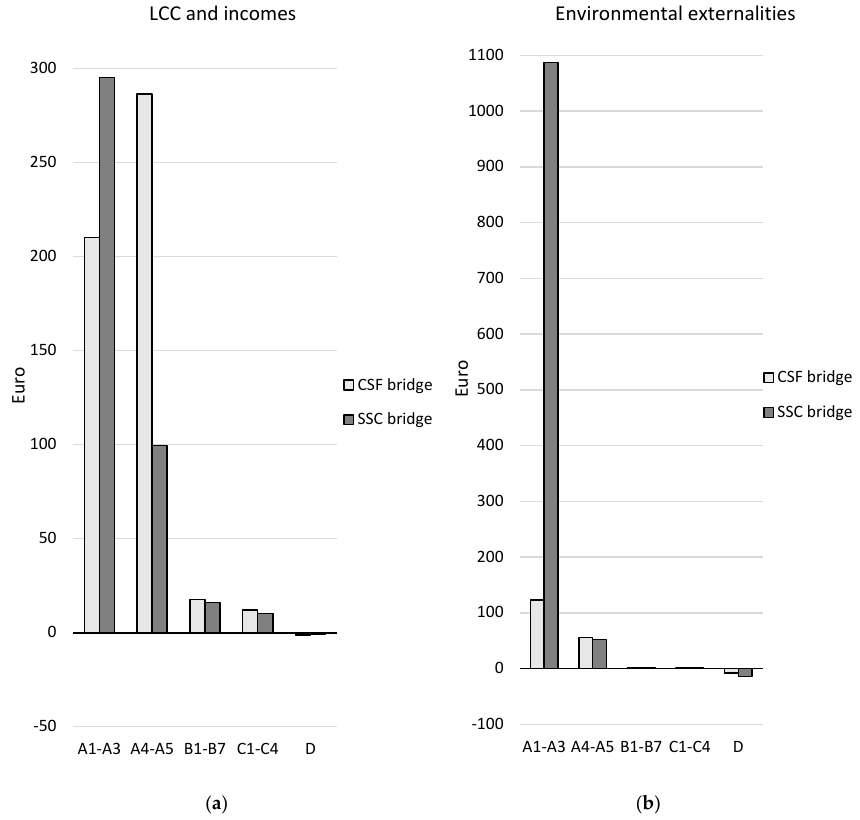
Figure 11. Comparison of the design concepts per life cycle stage for ( a ) the LCC and incomes and for ( b ) the environmental externalities presented in Euros for the functional unit. Module B8 is not included in the comparison. Note the different y-axis scales in the charts.